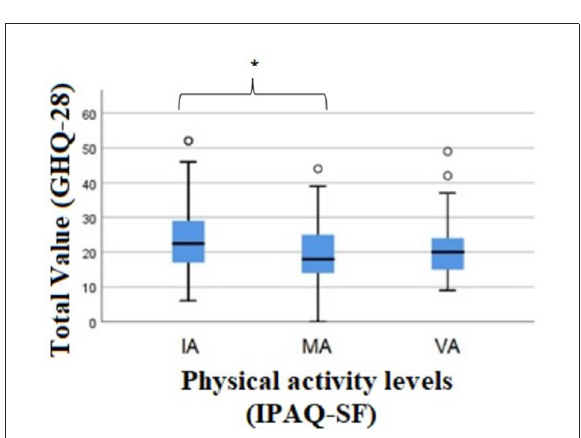
FIGURE3 Results of the Kruskal-wallis test for the comparison of total value (GHQ-28) between the levels of physical activity. GHQ-28, General Health Questionnaire-28; AI, Insufficiently Active; MA, Moderately Active; VA, Vigorously Active; PA, Physical Activity; IPAQ-SF, International Physical Activity Questionnaire; *Significant differences between the category IA and MA individuals ( p =